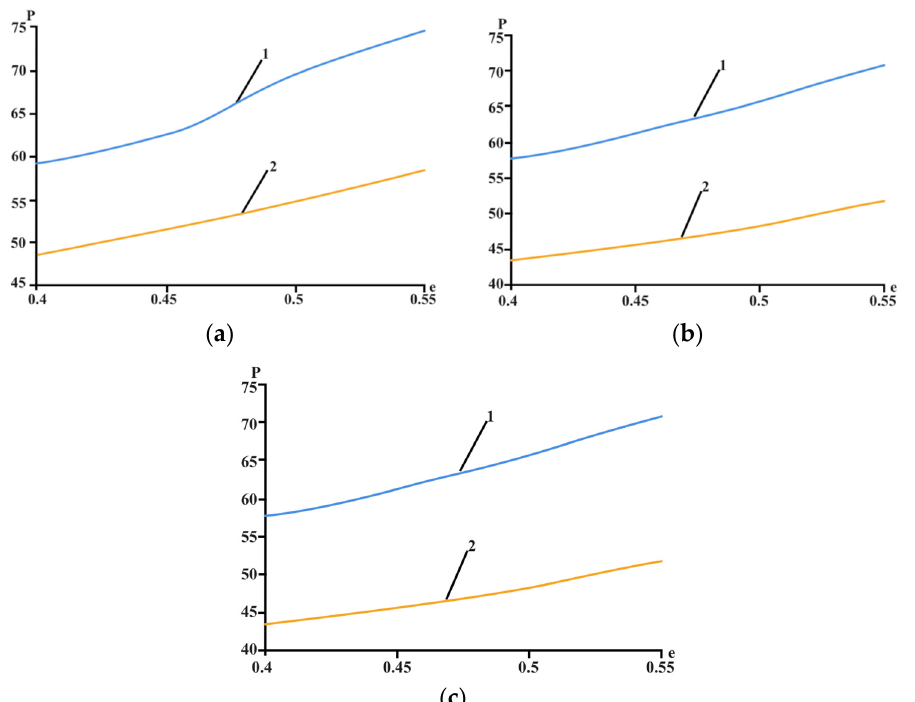
Figure 14. Dependence of the pressure of the top of K-1 and at the inlet to VOS 2 on the accepted fraction of distillate E of fuel oil in the furnace H-1: ( a ) the temperature of the service fluid t sl —35 °C; ( b ) t sl —25 °C; ( c ) t sl —15 °C.